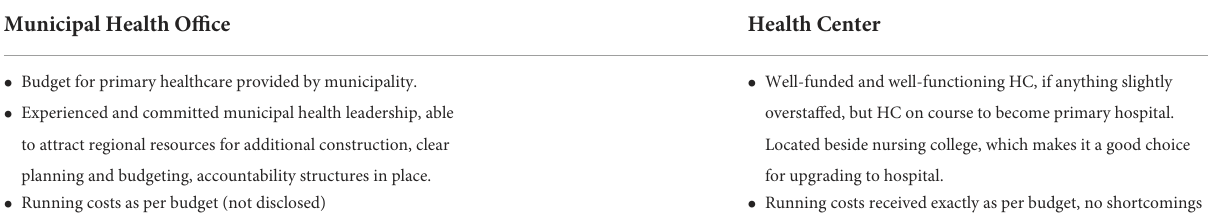
TABLE 2 Short case studies based on Woreda/Municipal Health Office - Health Facility visits. Case 2.1: Good municipal leadership, well-funded, well-run Health Center